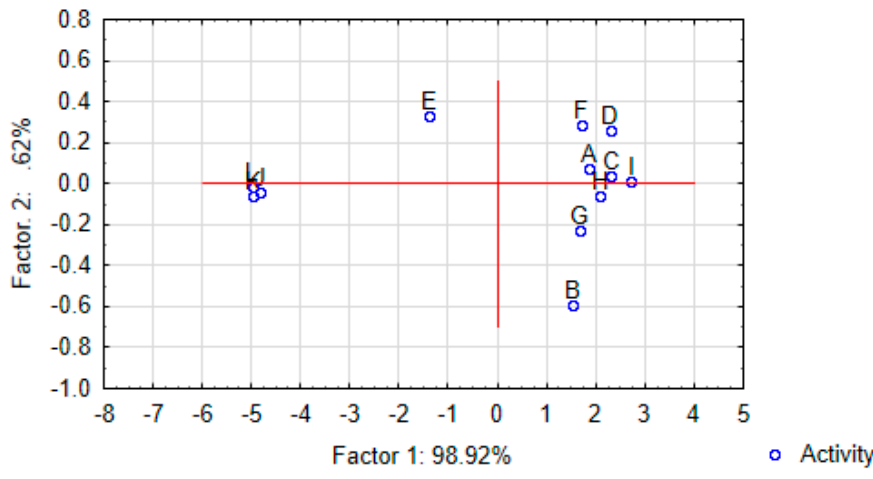
Figure 5. Map of the variants of gnocchi dumplings with thiamine hydrochloride and thiamine pyrophosphate carriers (Muscat Pumpkin, Hokkaido Pumpkin, Cauliflower, Broccoli) and the control sample (without carriers) into factors (“F1xF2”). Case-factor coordinates plots based on attributes of taste profiles and data from consumer analysis (A—salty taste; B—vegetable taste; C—bitter taste; D—peppery taste; E—flour taste; F—potato taste; G—sweet taste; H—chemical taste; I—metallic taste; J—taste desirability and K—overall desirability) (PCA analysis). Table 3. Mean scores ( n = 14) of sensory taste profiling and desirability ( n = 199) of gnocchi dumplings with vegetables fortified with thiamine hydrochloride (TCh) and thiamine pyrophosphate (TP) and the control sample (without vegetable fortified of thiamine addition).